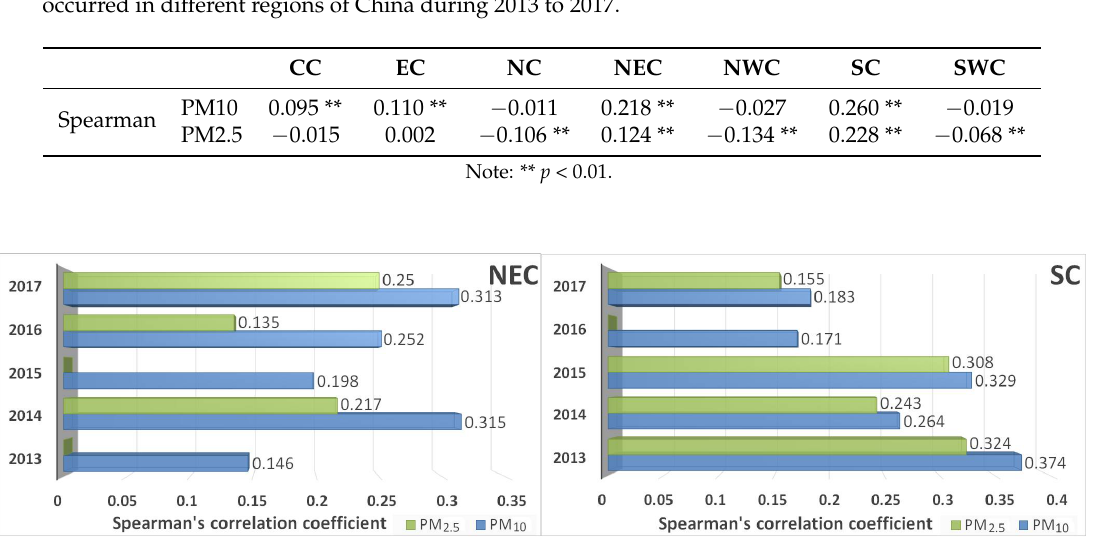
Figure 10. Interannual variations of correlation coefficient between PM concentrations and crop residue burning in Northeast China (NEC) and South China (SC).